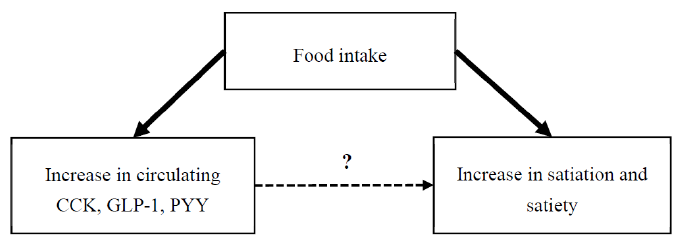
Figure 1. Food intake induces an increase in circulating gastrointestinal peptides CCK, GLP-1 and